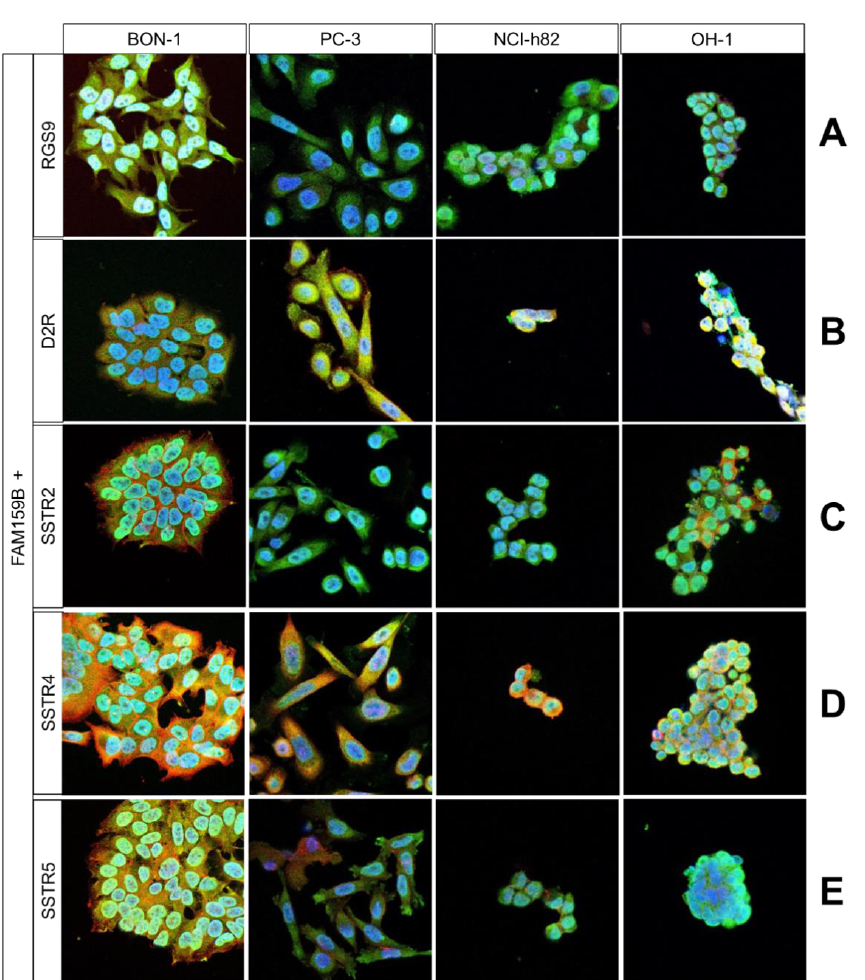
Figure 4. Double-labelling immunocytochemical analysis of FAM159B and regulator of G-protein signalling (RGS9; ( A )), dopamine receptor 2 (D2R; ( B )), somatostatin receptor 2 (SSTR2; ( C )),